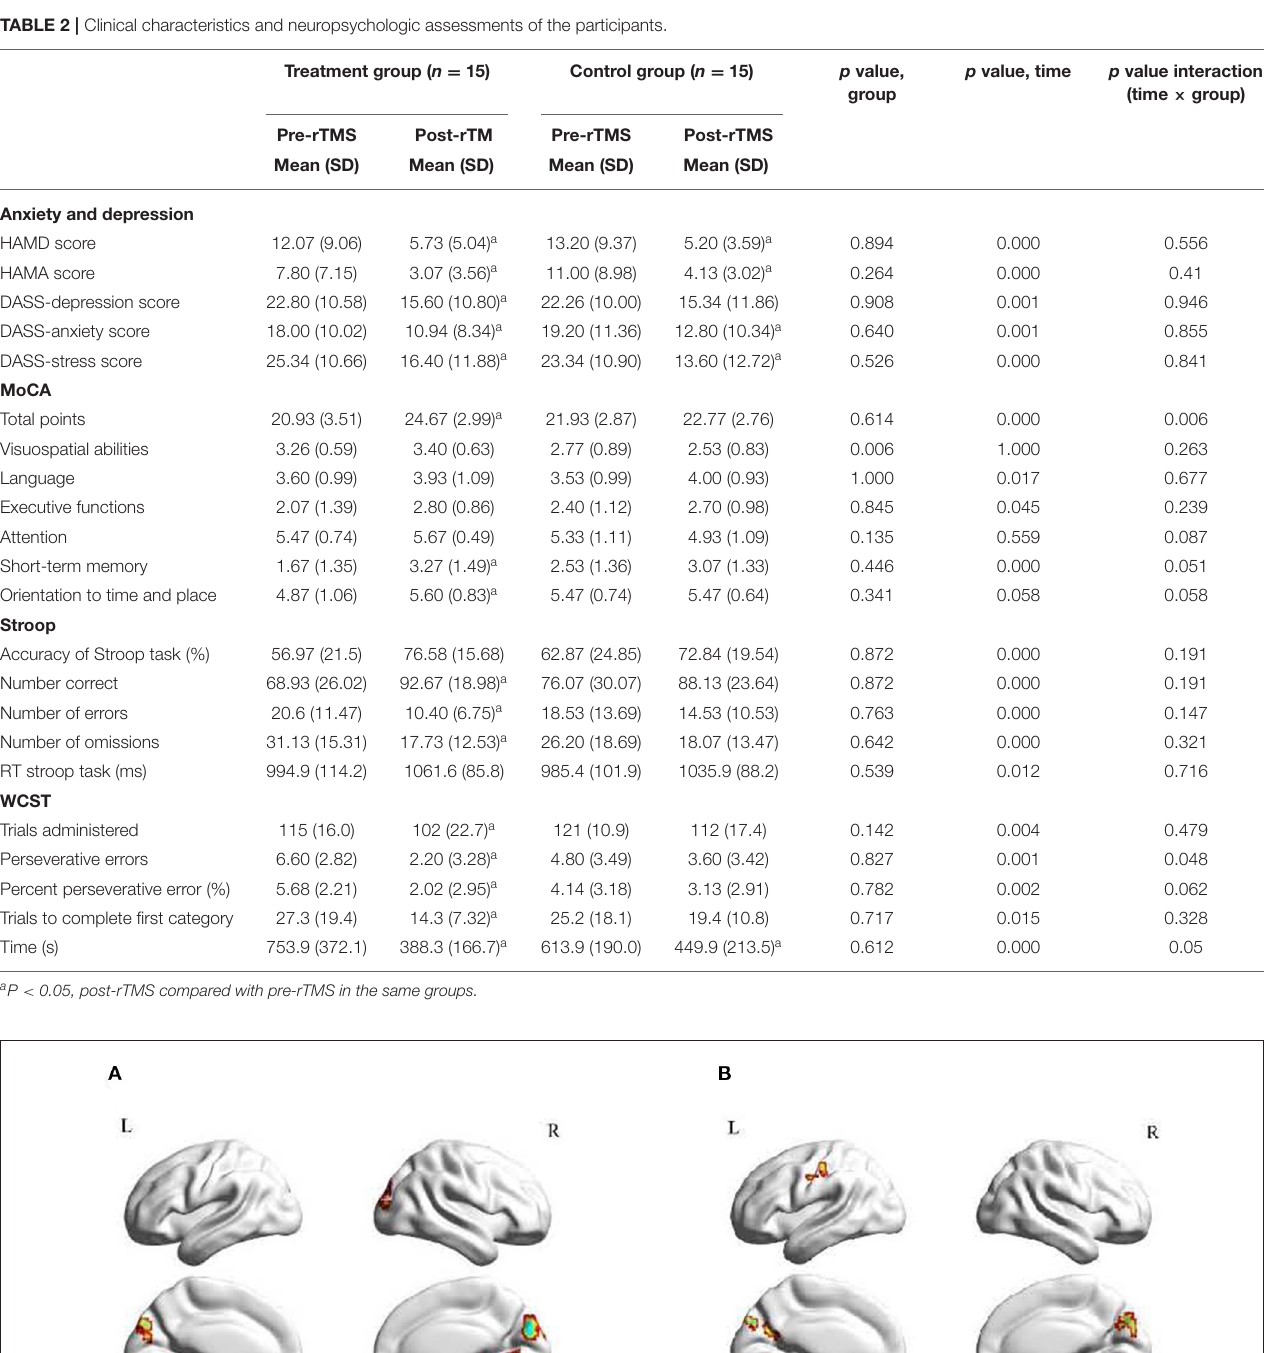
TABLE 2 | Clinical characteristics and neuropsychologic assessments of the participants. Treatment group ( n = 15) Control group ( n = 15) p value,